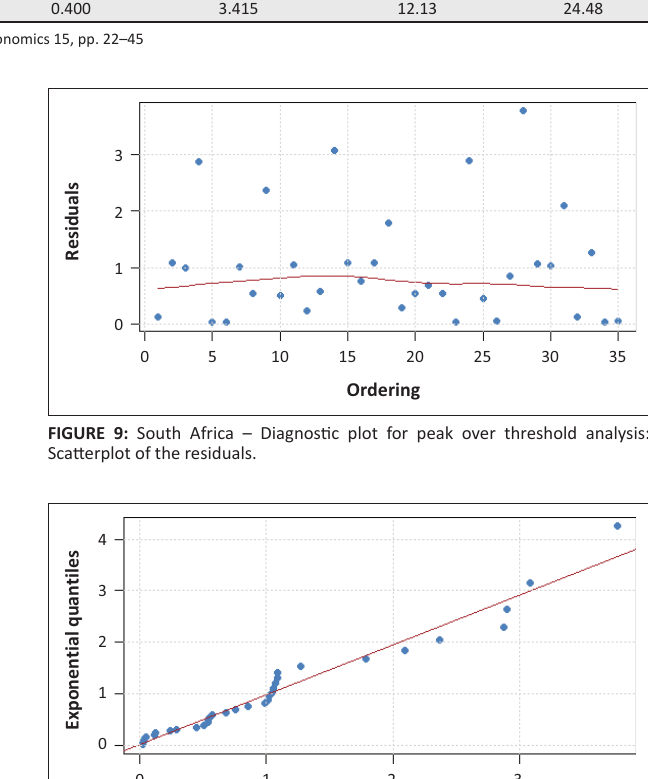
TABLE 6: South Africa – Generalised Pareto distribution: Peak over threshold estimation results for the exchange market pressure series. Percentage of observations above the threshold ( %